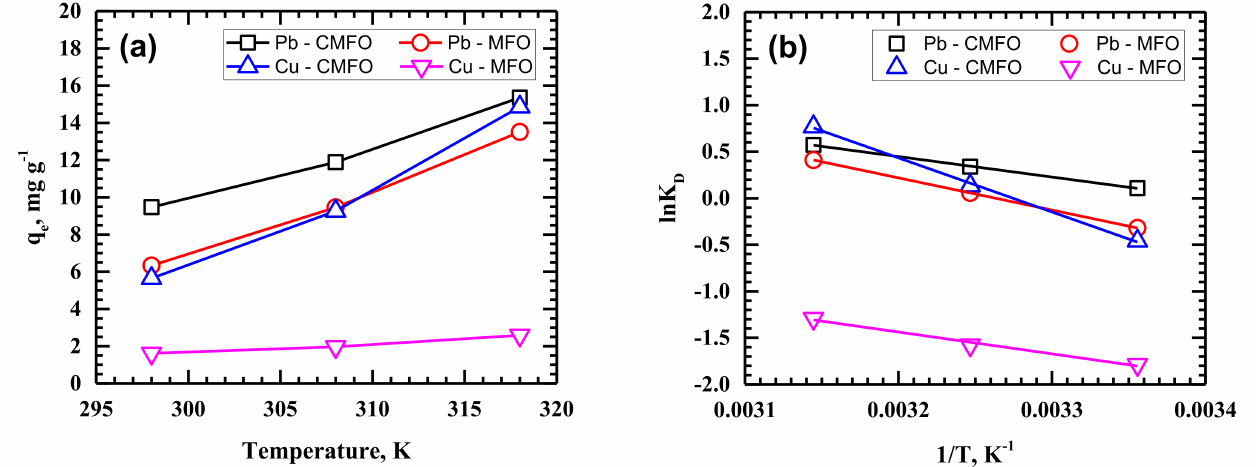
Figure 5. ( a ) Effect of temperature on the uptake of Cu(II) and Pb(II) by CMFO and MFO and ( b ) thermodynamic plot of ln K D against 1/ T of Cu(II) and Pb(II) uptake on CMFO and